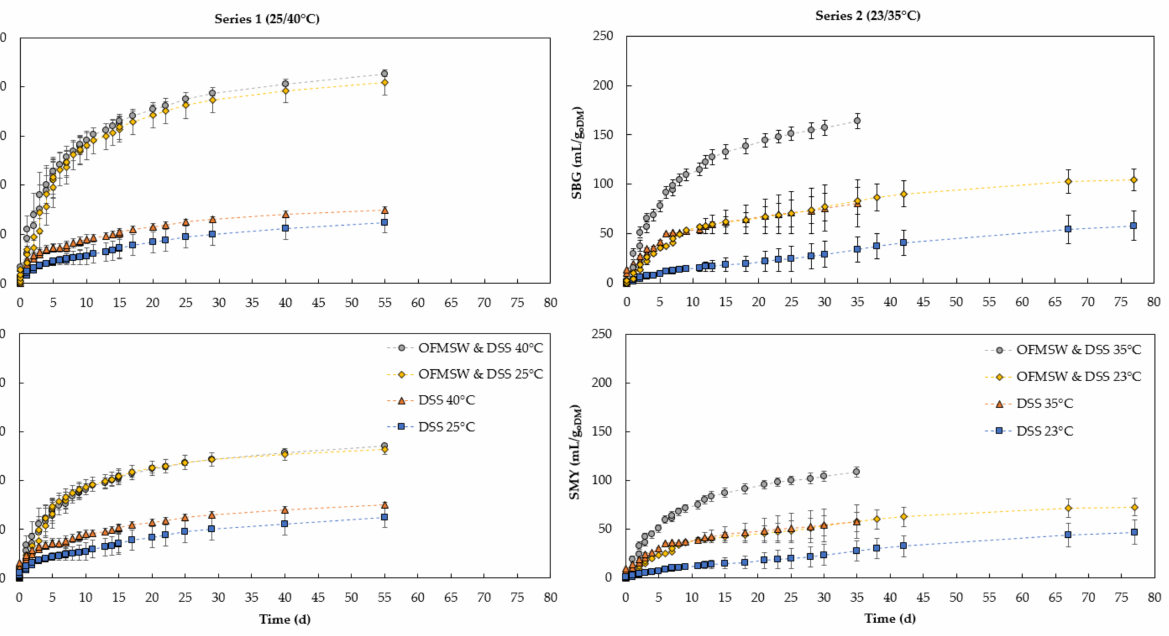
Figure 1. Specific biogas yield (SBG) and specific methane yield (SMY) for the mixture of the organic fraction of municipal solid waste (OFMSW) and digested sewage sludge (DSS); mean values ± standard deviation (n = 2 for DSS, n = 4 for OFMSW and DSS) based on organic dry matter (oDM), gas volume at 1013 hPa, 0 ◦